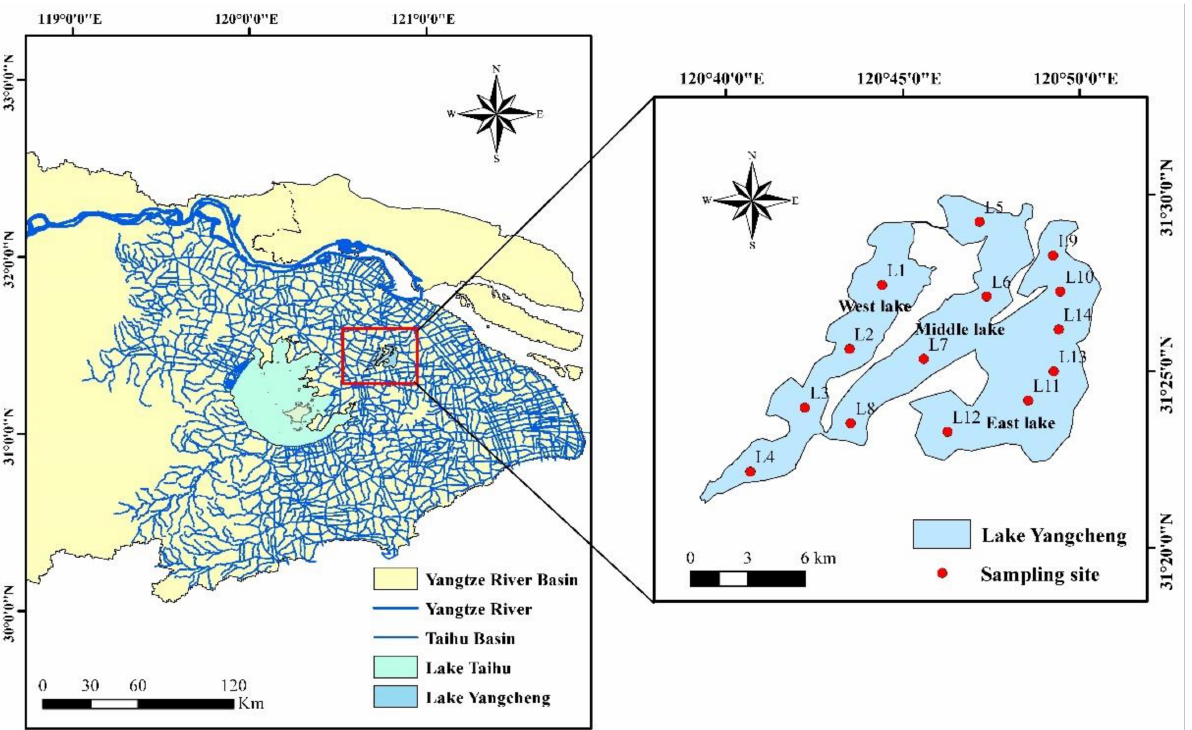
Figure 1. Map of Lake Yangcheng and the locations of sampling sites in this